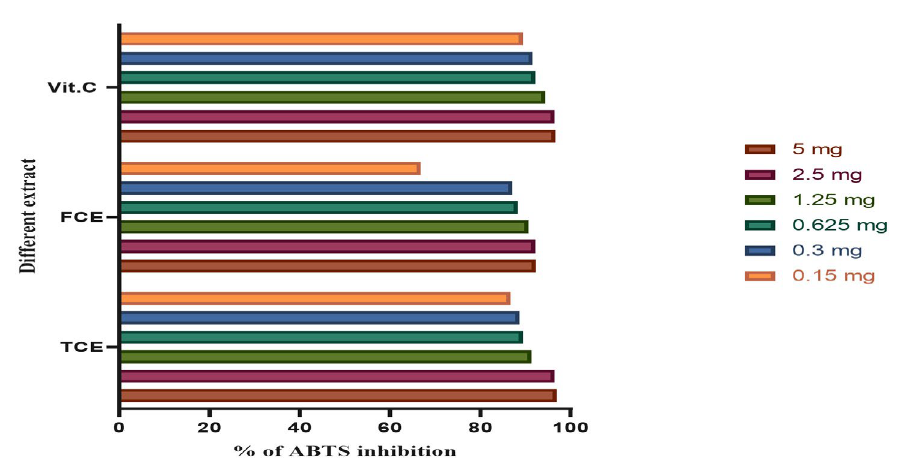
Fig. 5. The anti-inflammatory activities of vitamin C (Vit C), the total culture extract (TCE), and the free cell extract (FCE) .